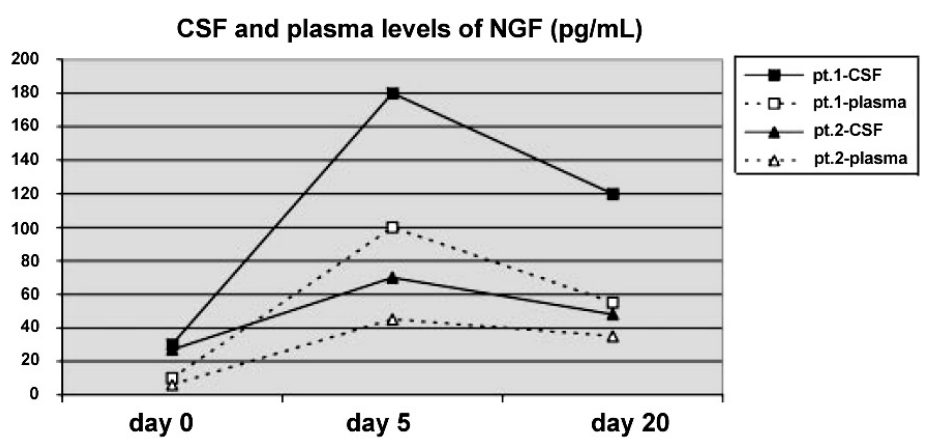
Figure 3. Cerebrospinal fluid (CSF) and plasma levels of NGF (pg/mL) before, during and after the 10 day course of intraventricular NGF infusion in the two infants. The detection limit was 3